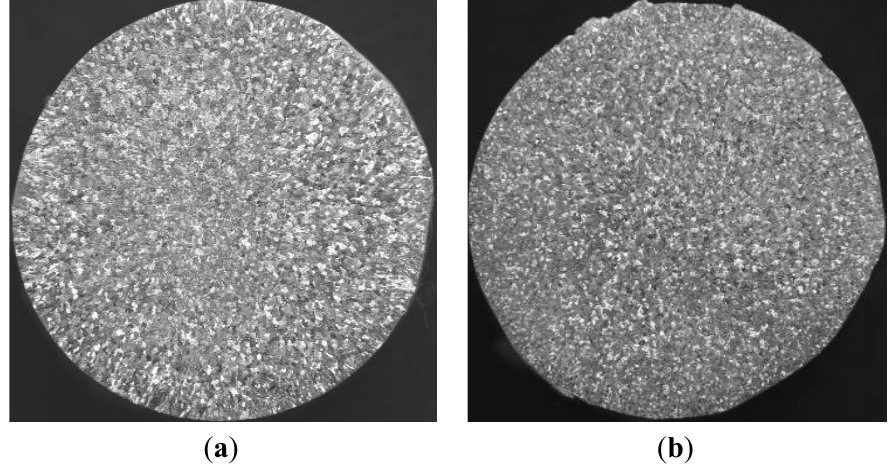
Figure 7. Effects of different additions of Al–5Ti master alloy 1 # on grain size of solidified commercial pure aluminum sample (holding for 5 min): ( a ) 1.0%; ( b ) 1.6%; ( c ) 2.0%; ( d )